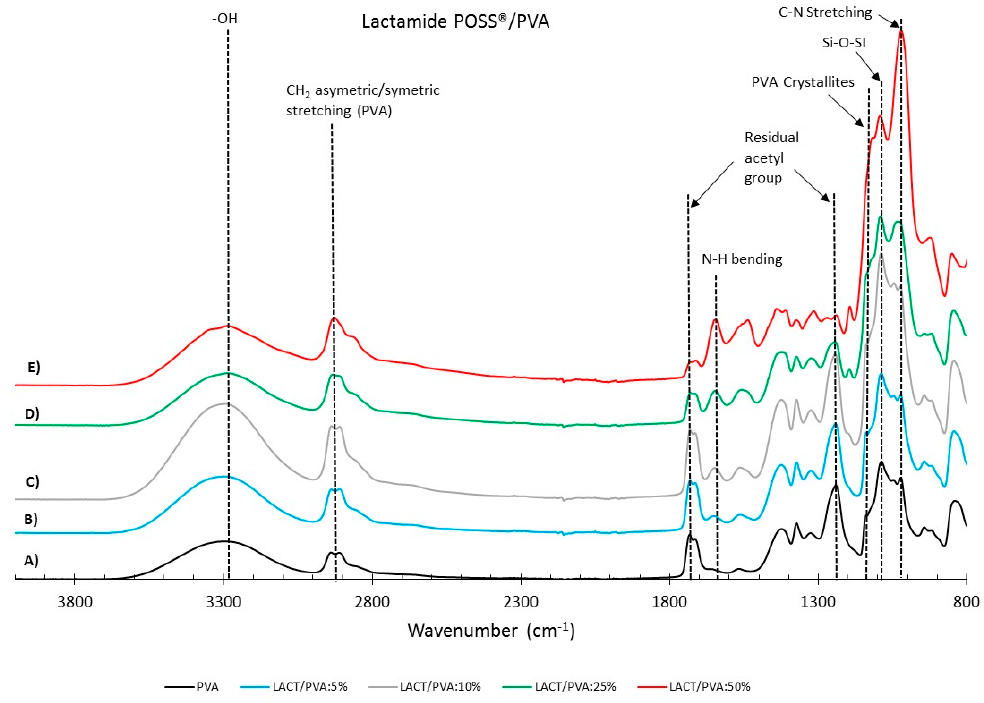
Figure 5. FTIR reflectance of (A) pure PVA, Lactamide POSS ® /PVA: (B) 5%; (C)10%; (D) 25%; (E) 50%. The curves are shifted vertically for clarity.